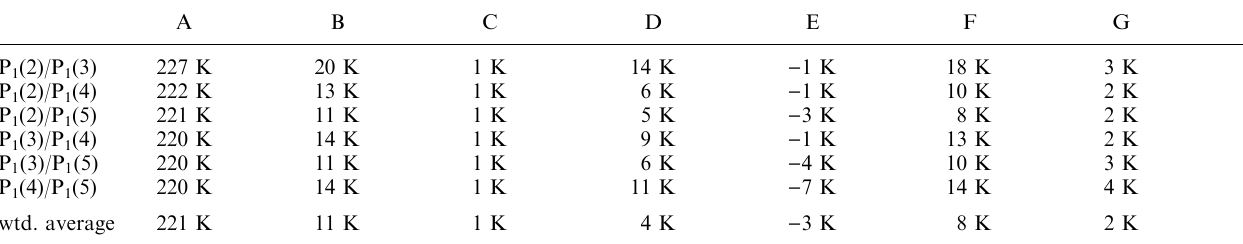
Table 4. Average temperatures and uncertainty estimates for individual ratios and the weighted temperature (see text) for the expanded data set (see text, 277 spectra): (A) average temperatures; (B) standard deviation; (C) standard error in the mean; (D) average ‘counting’ error for individual spectra; (E) average auroral correction; (F) average error in individual spectra; (G) estimated error in average temperatures. A B